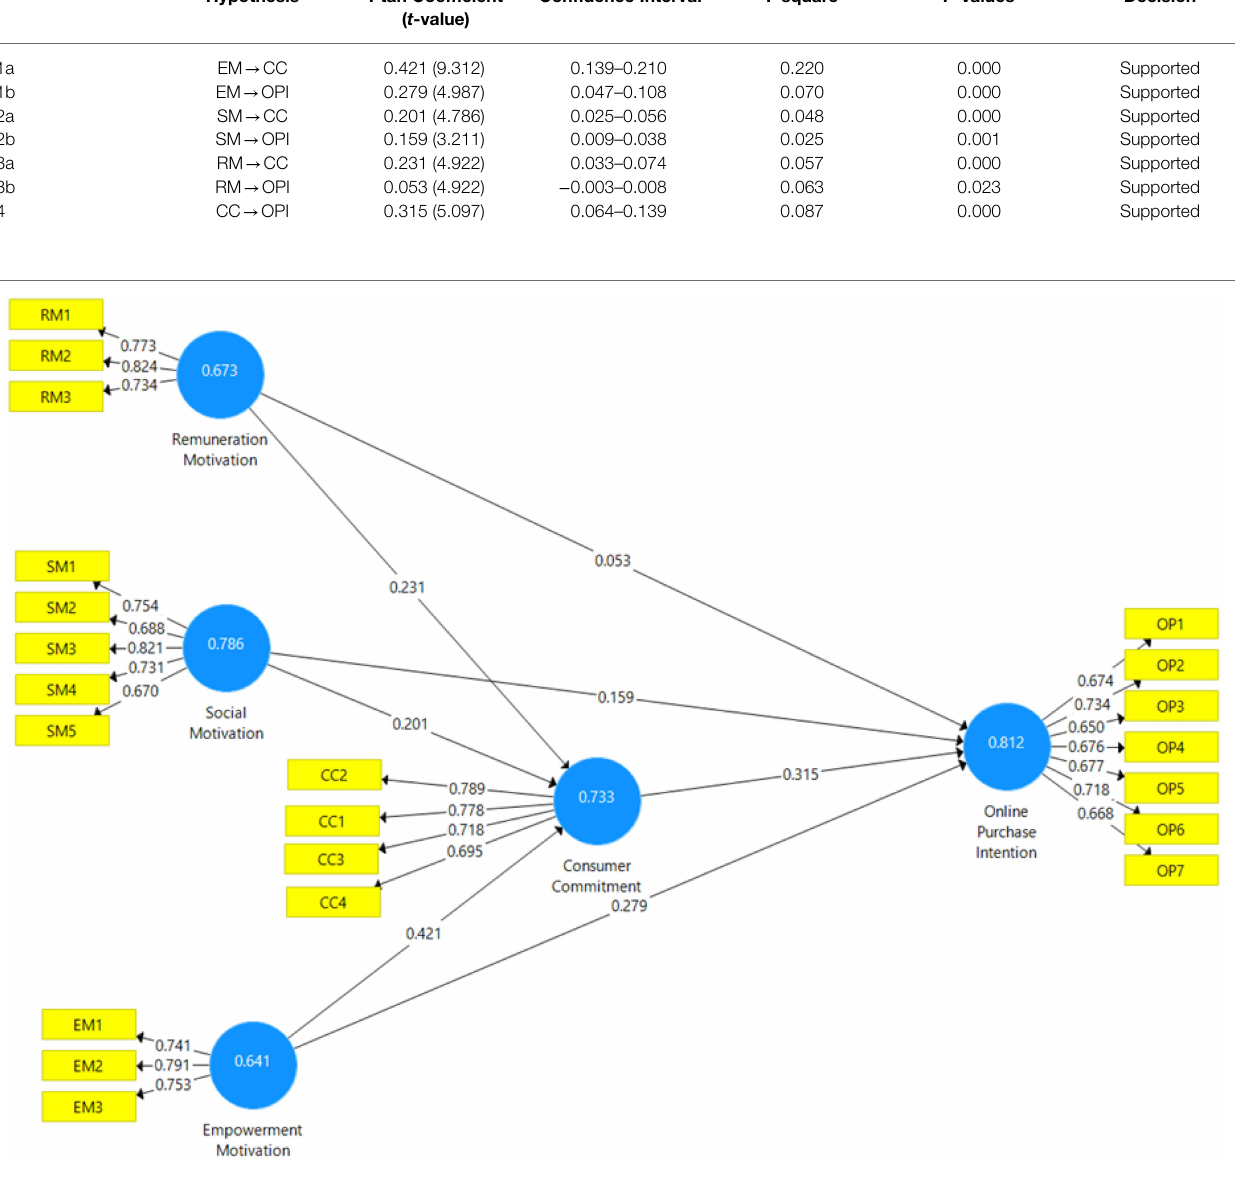
FIGURE 3 | Measurement